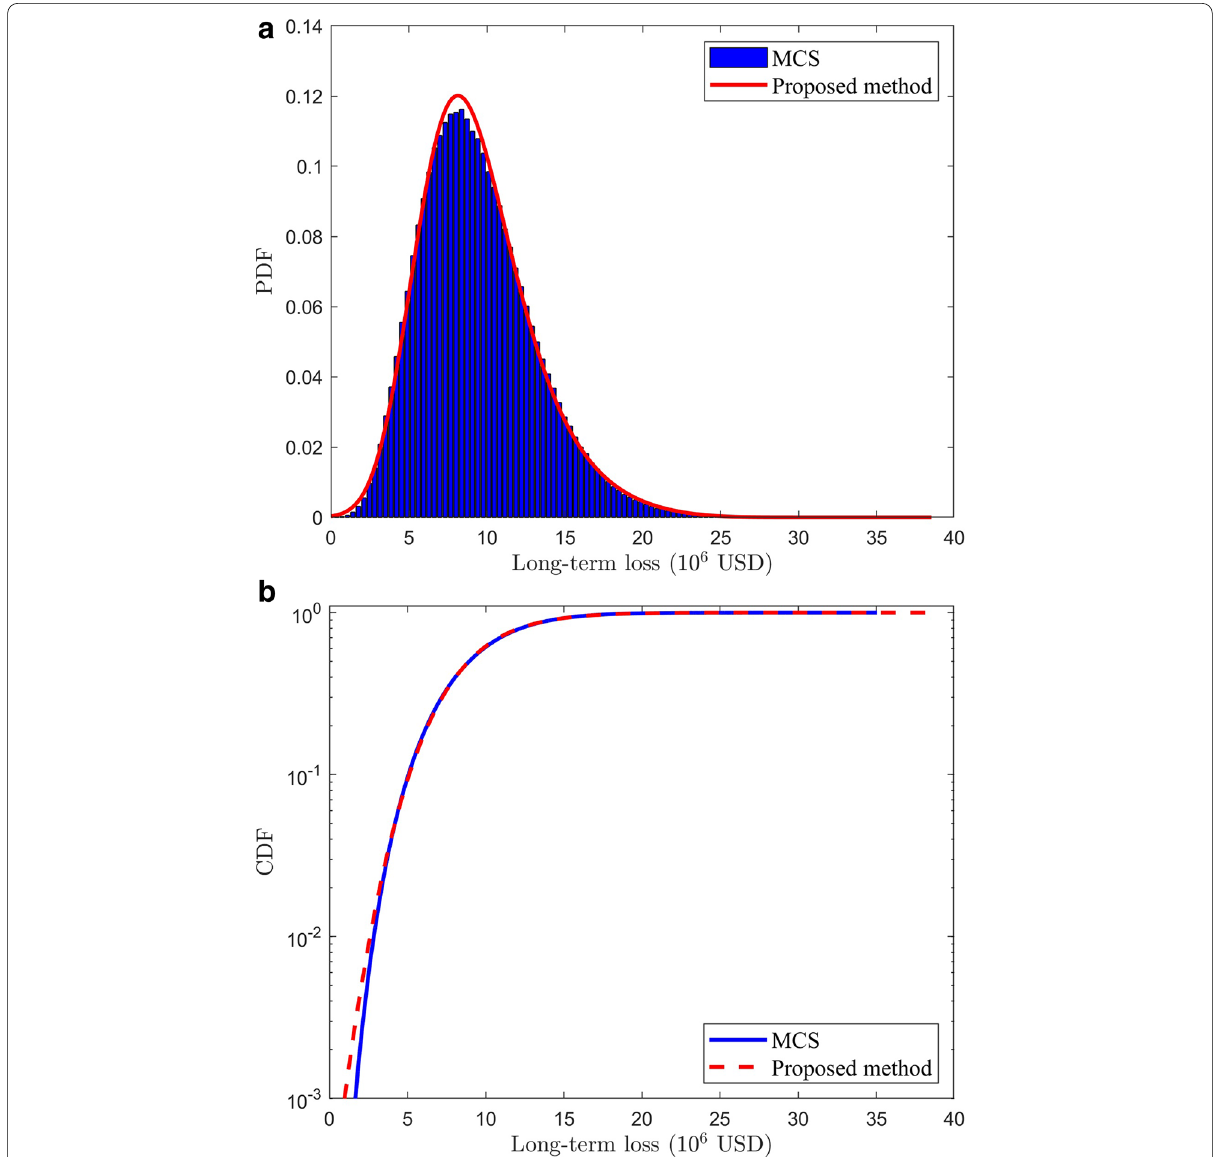
Fig. 5 ( a ) PDF and ( b ) CDF of long-term loss obtained by Monte Carlo simulation and proposed method (75 years, r